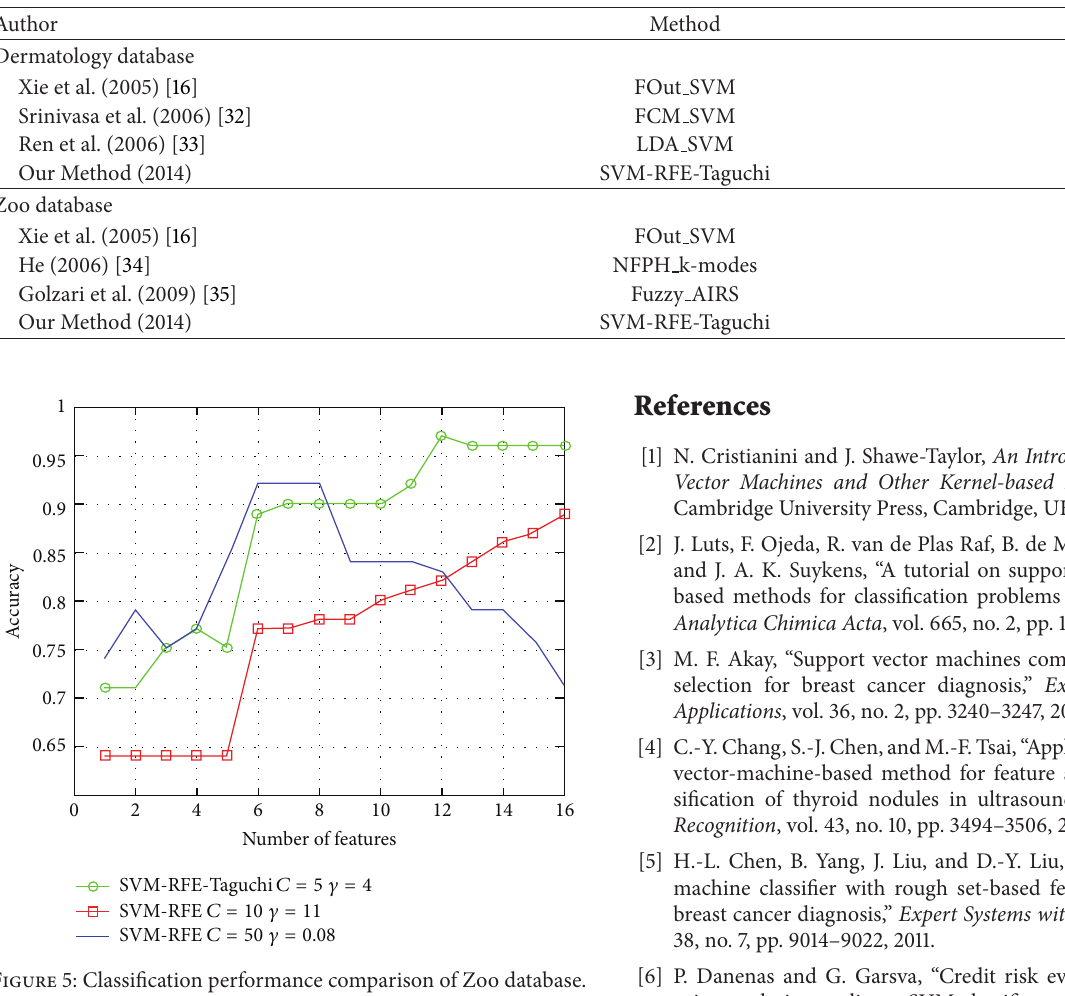
Table 11: Comparison of classification accuracy in related literature.